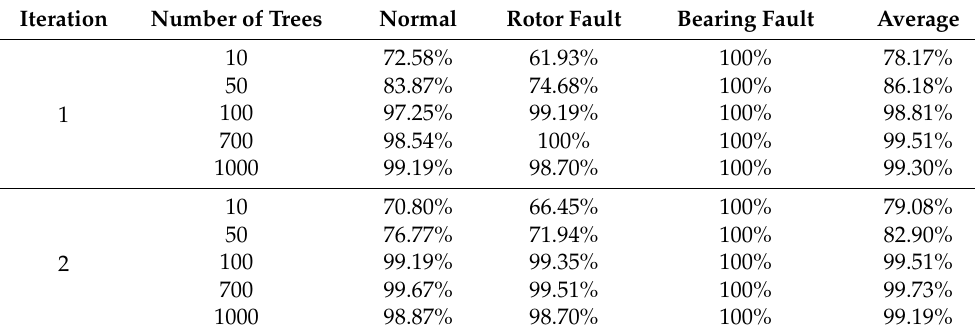
Table 10. Diagnostic accuracy of XGBoost for cross-validation.